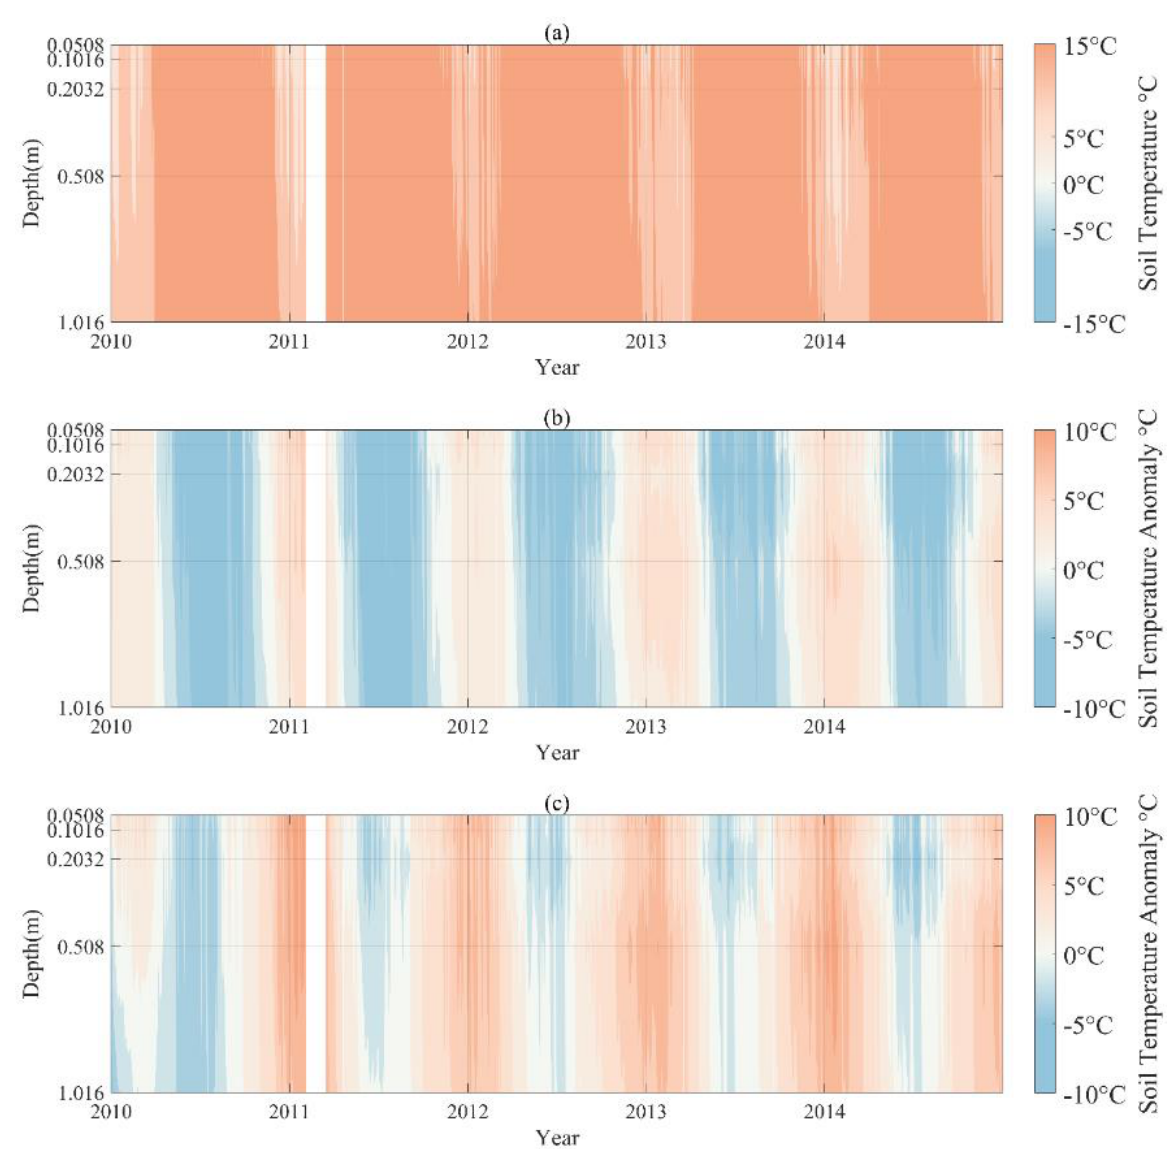
Figure 15. Soil temperature vertical profiles at Little River from 2010 to 2014: ( a ) is observations, ( b ) the difference between CLM5’s simulation and observations, and ( c ) the difference between CoLM2014’s simulation and